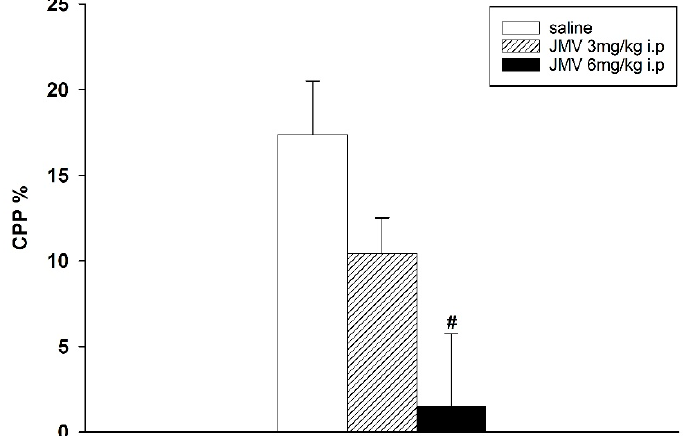
Figure 2. Effects of GHS-R1A antagonist on 5 mg/kg methamphetamine-induced CPP in rats. After eight days of conditioning with 5 mg/kg i.p. methamphetamine, JMV2959 was administered in a single dose 20 min before testing ( N = 8; means ± SEM). Effects of JMV2959 pretreatments in comparison to the saline group are expressed as # p < 0.05.